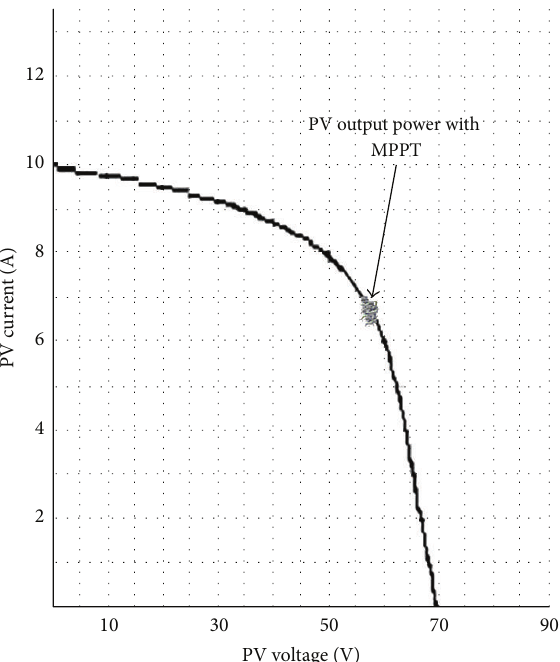
Figure 19: Measured result: operation point of PV panel after MPPT.